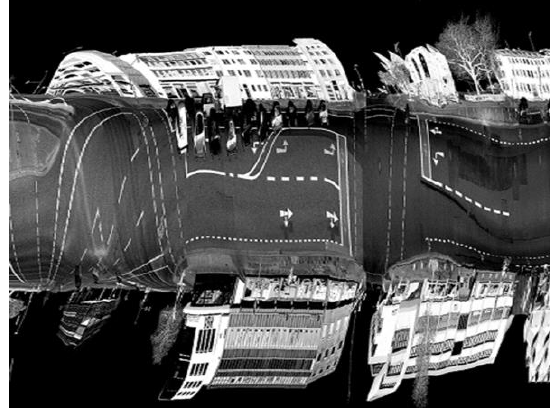
Figure 3: Intensity Image obtained from laser